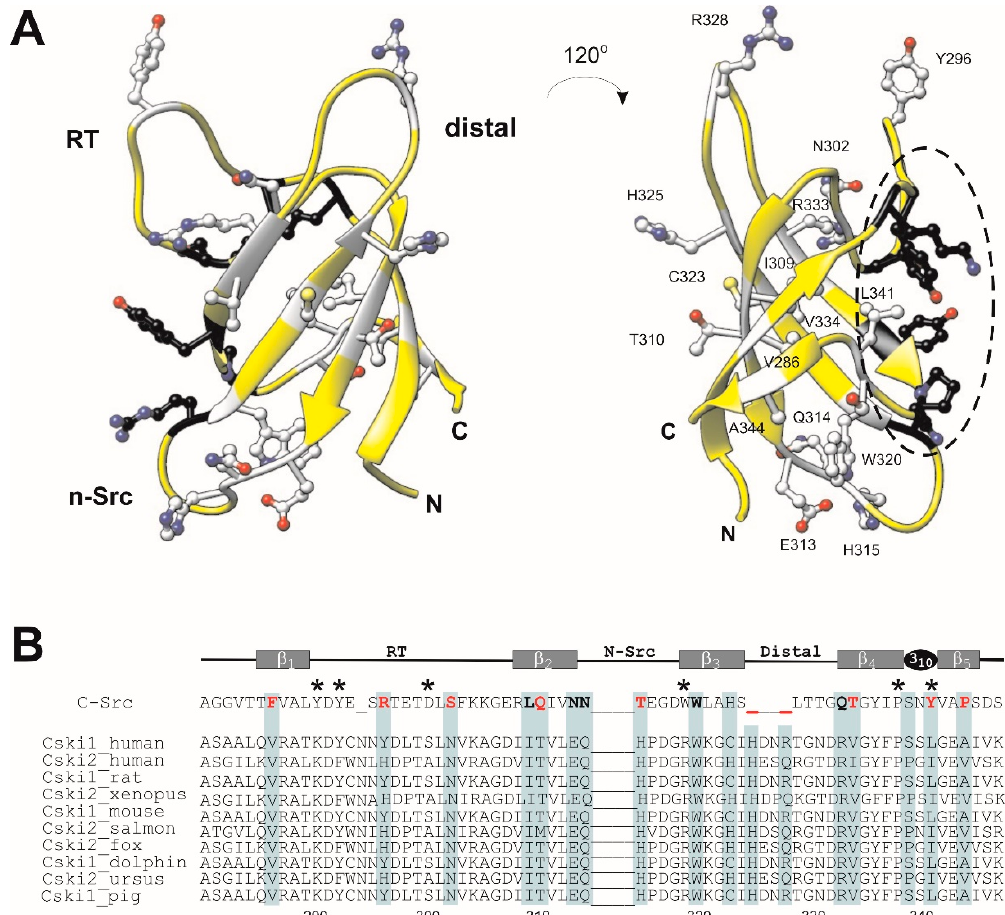
Figure 5. Interaction of human Caskin1 SH3 with oleoyl LPA. ( A ) Representative element of the lowest-energy structural ensemble of the SH3 domain of human Caskin1 highlighting the residues with above average oleoyl LPA-induced (lipid-to- protein molar ratio of 10:1) backbone ( 1 H, 15 N) chemical shift change (Figure S1). The region corresponding to the peptide binding groove in the SH3 domain of Src kinase are shown in black. ( B ) Sequence alignment of selected Caskin1 and Caskin2 SH3 domains. Residues with chemical shift change exceeding the average upon the addition of LPA are highlighted in blue revealing a high degree of conversion in Caskins. The sequence of the SH3 domain of c-Src is shown at the top for comparison together with the secondary structure elements. Non-conserved amino acid replacements affected by LPA binding is indicated in red. Amino acid positions corresponding to the peptide binding groove in c-Src are marked by an asterisk. The SH3 sequences shown as follows. Src: c-Src, Gallus gallus (UniProt P00523); Caskin1, Homo sapiens